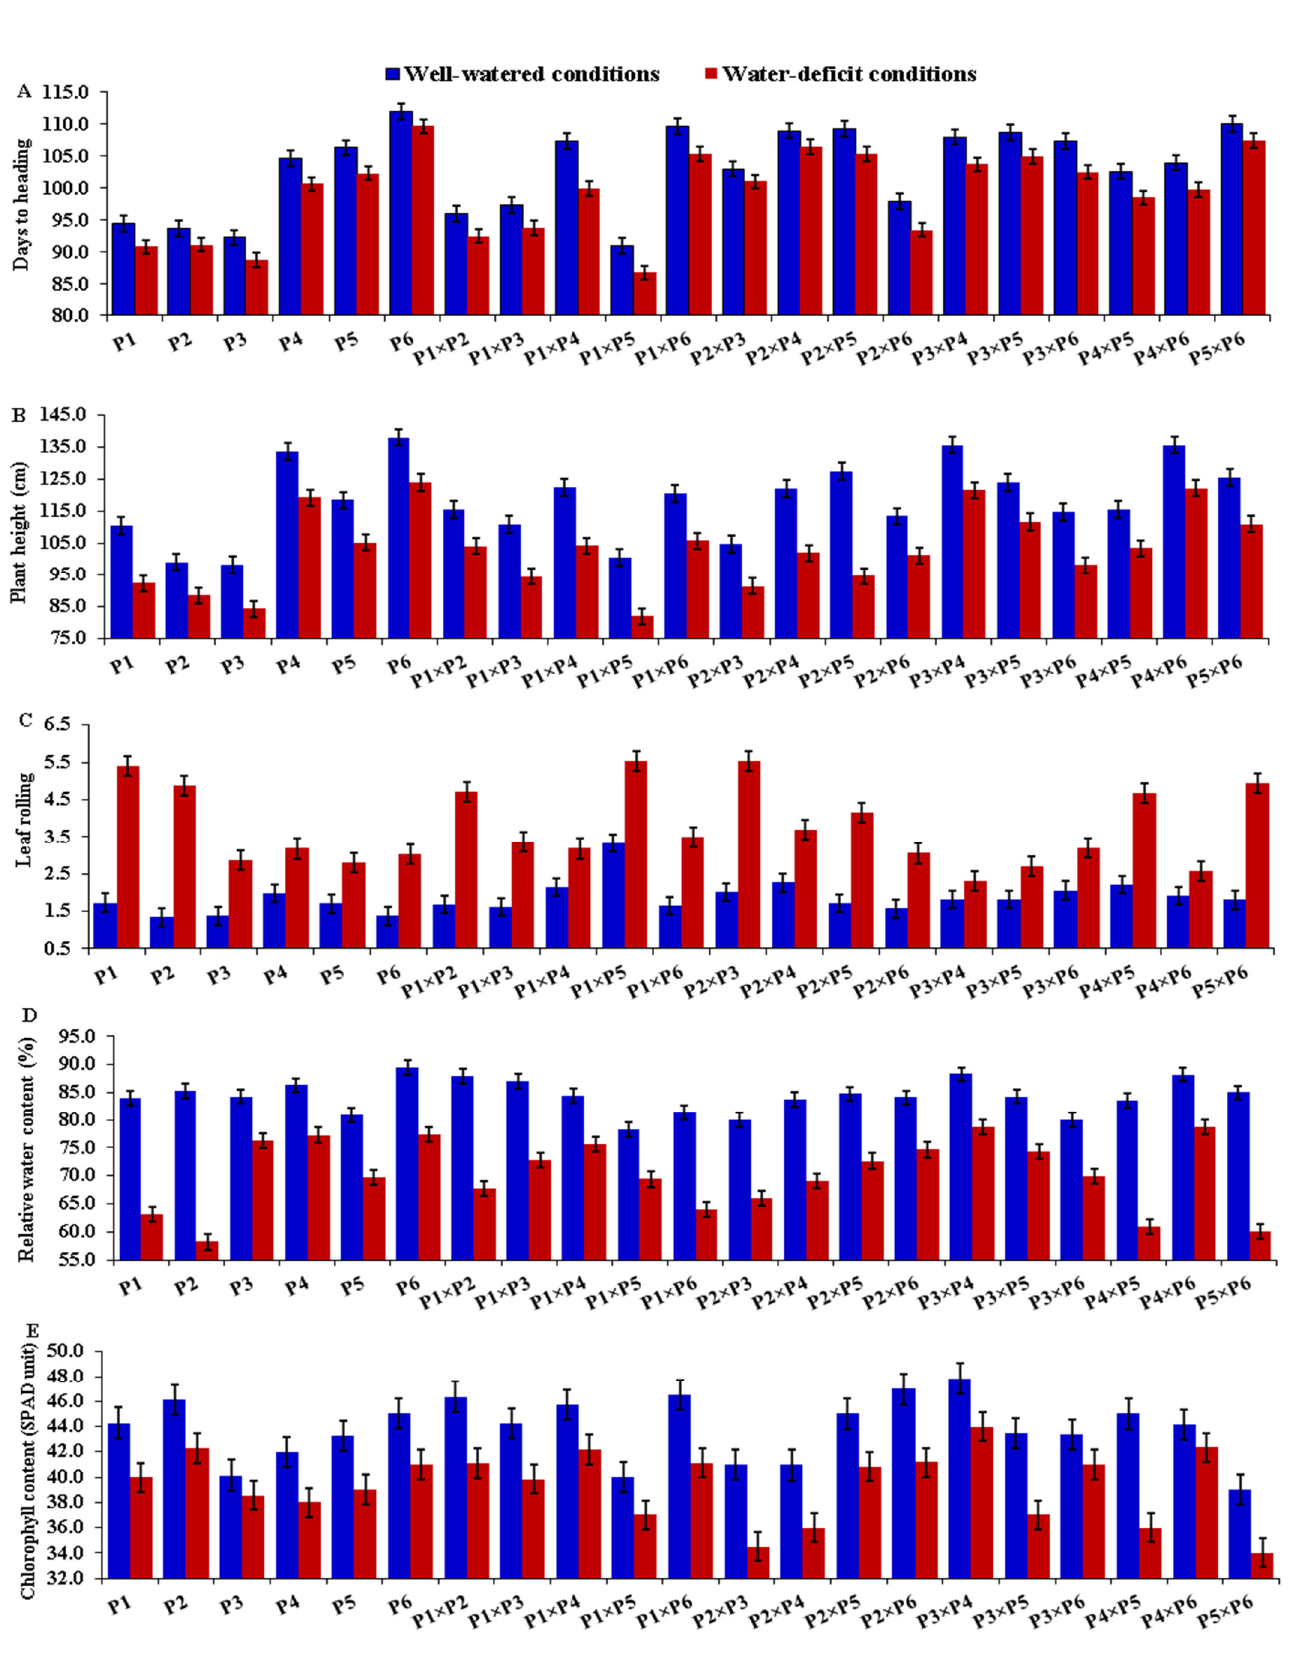
Figure 2. Mean performance of the six rice parents and their 15 F 1 crosses for days to heading ( A ), plant height ( B ), leaf rolling ( C ), relative water content ( D ), and chlorophyll content ( E ) under well-watered and water-deficit conditions. The bars on the columns correspond to LSD ( p ≤ 0.05).